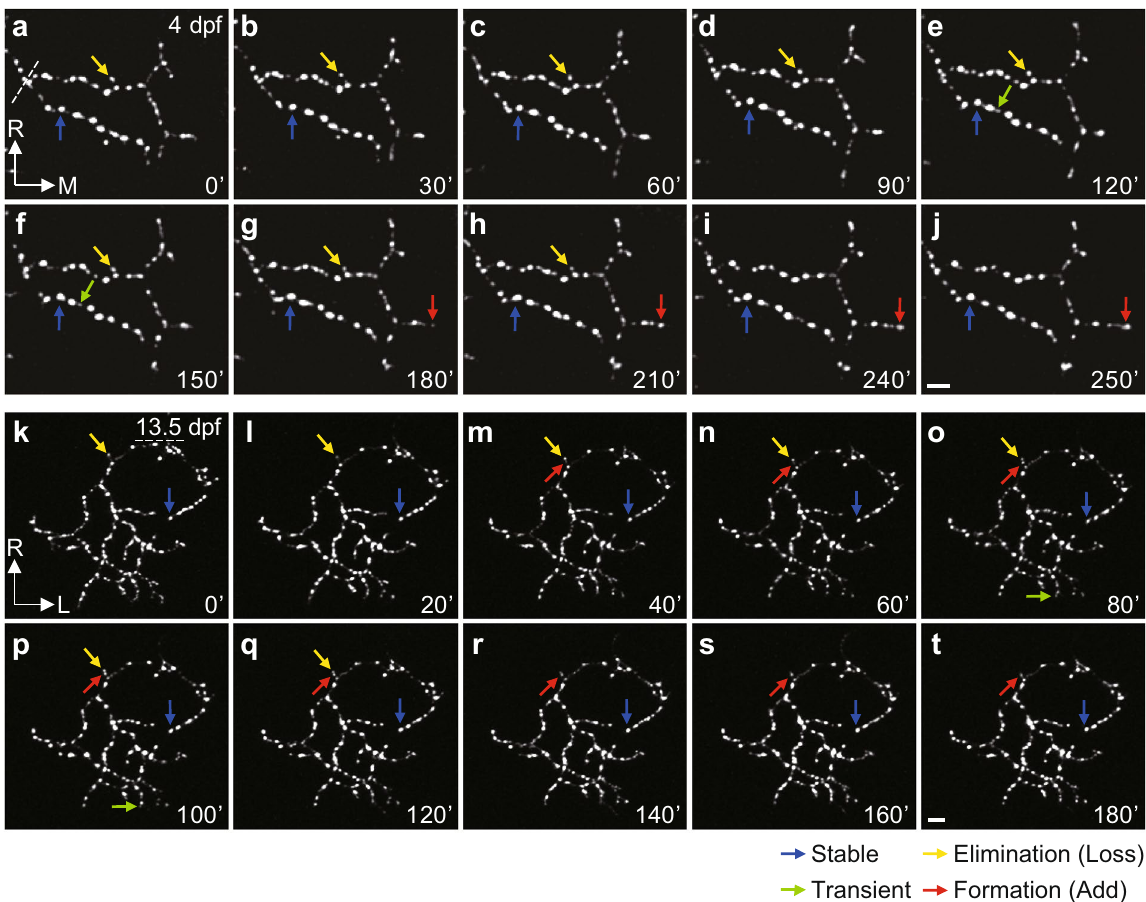
Figure 3. Remodelling of Sypb-EGFP puncta on the axonal arbor of individual RGCs. ( a–t ) Time-lapse two- photon images of individual RGC axonal arbor expressing Sypb-EGFP showing synaptic remodelling at both early (4 dpf, a–j ) and late (13.5 dpf, k–t ) larval stages, respectively. At 13.5 dpf, we used pigment mutants of PGUSG ( PGUSG ; casper ). Arbors were imaged at 10 min intervals for at least 3 h. Time in minutes is indicated in the bottom right corner of each panel. The coloured arrows indicate examples of puncta with different behaviours: stable (blue), existing through the entire imaging time period; elimination (yellow), existing at the beginning but lost during imaging; transient (green), newly added during imaging but lost before the end of imaging; formation (red), newly added during imaging and maintained till the end of imaging. L, lateral; M, medial; R, rostral. Scale bar, 5 μ